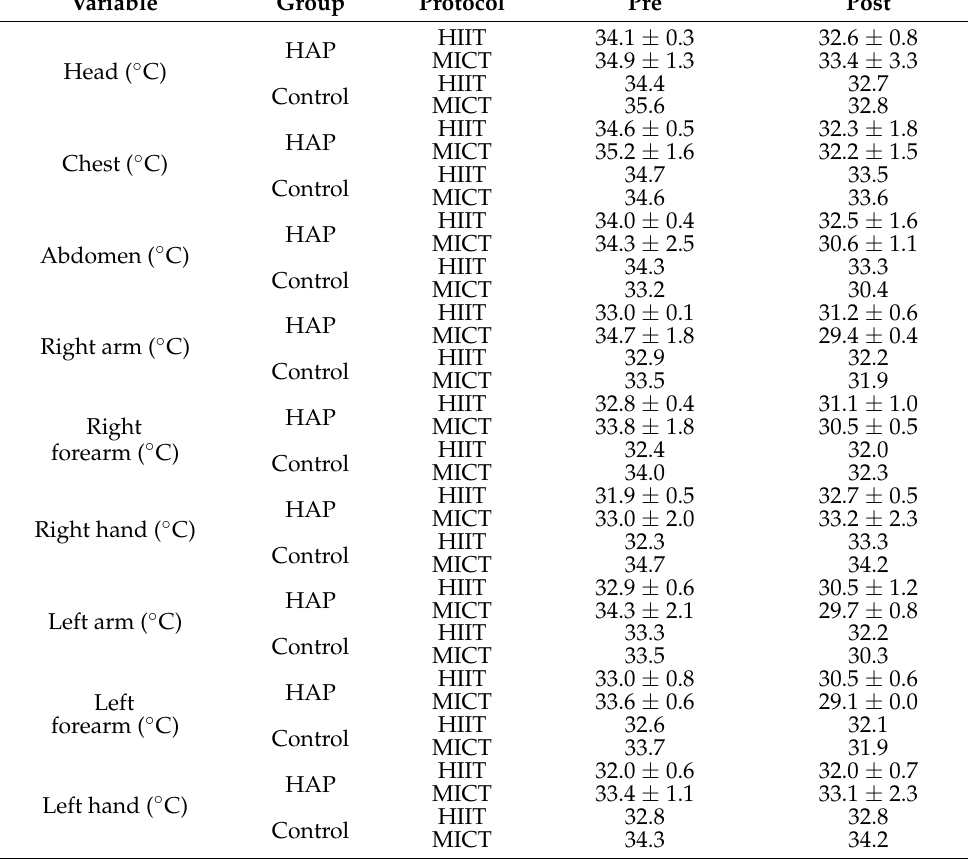
Table 2. Temperature in ◦ C by thermography analysis in heart attack patients and control in the high-intensity interval training (HIIT) and moderate-intensity continuous training